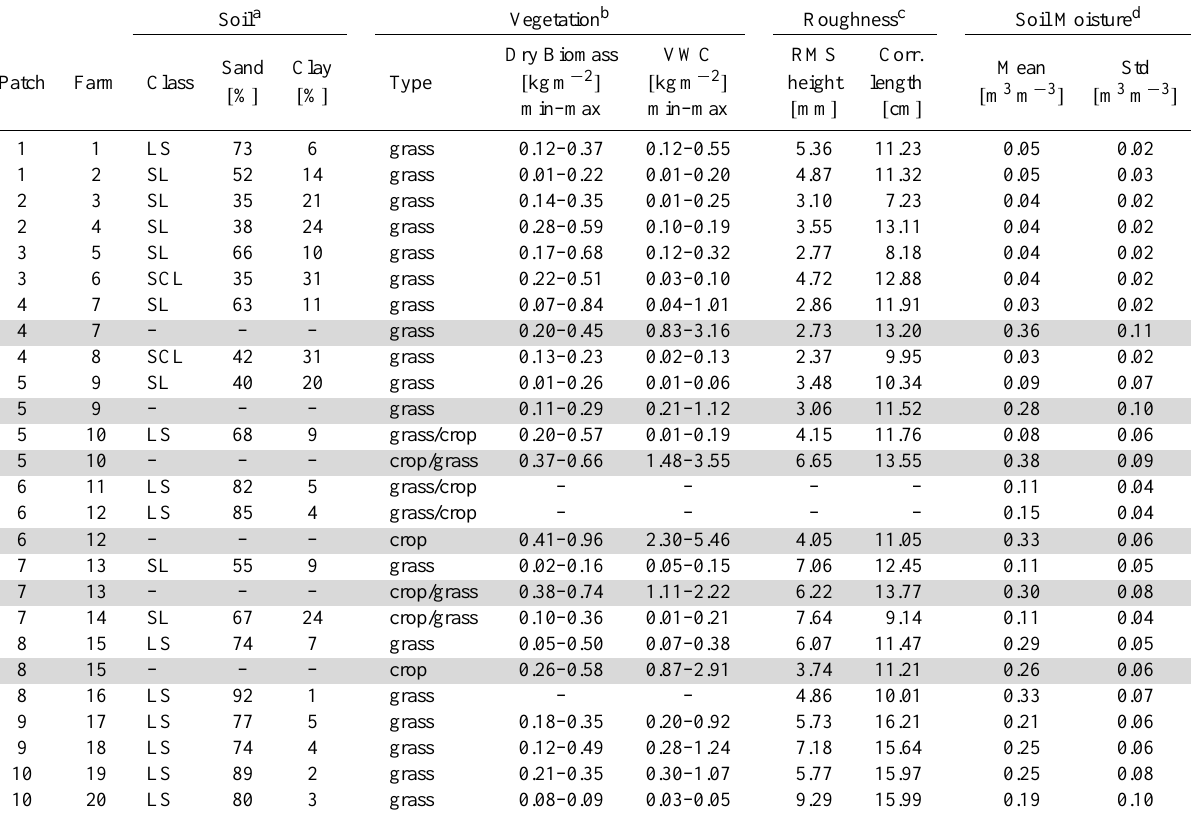
Table 2. Characteristics of all focus farms sampled during AACES-1 and AACES-2 (shaded rows). Soil a Vegetation b Roughness c Soil Moisture d Sand Clay